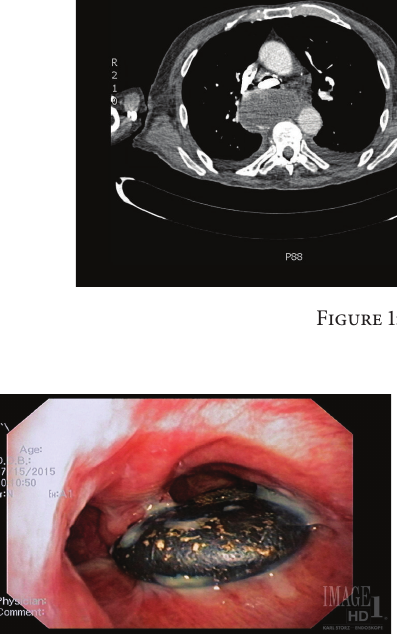
Figure 2: Bronchoscopy image showing the foreign body in the